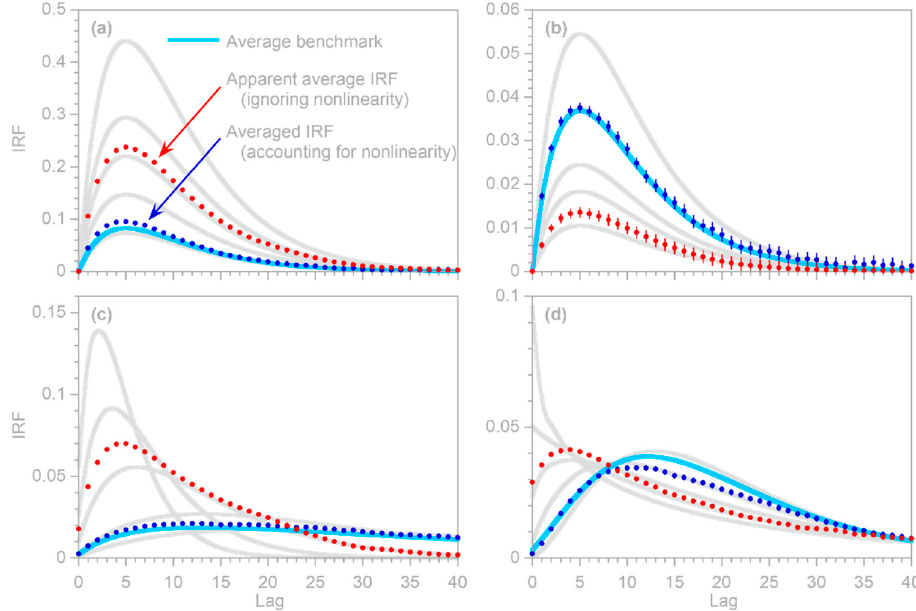
Figure 14. Bias in apparent average impulse response in four nonlinear benchmark systems. Bench ‐ marks include ( a ) quadratic relationship between input and output (Figure 10); ( b ) Michaelis–Men ‐ ten relationship between input and output (Figure 11e); ( c ) gamma mean lifetime decreases with increasing input (Figure 12); ( d ) gamma shape factor decreases with increasing input (Figure 13). Test procedures are identical to Figures 10–13, except signal ‐ to ‐ noise ratio is 100 so that mean IRFs are shown with minimal scatter. Gray lines show benchmark impulse responses at knot values 𝑥 (cid:3404) 𝜅 ℓ ; these are not evenly spaced either in 𝑥 or in percentiles of 𝑥 , and thus the spacing between the gray lines does not indicate the underlying degree of nonlinearity. Light blue lines show the average benchmark impulse response functions for each system, averaged over all values of 𝑥 . Dark blue points show the average impulse response functions estimated from Equations (43) and (47). These estimates generally follow the average benchmarks. Dark red points show naïve estimates of impulse response functions estimated using the methods of Sections 2.1–2.4, without accounting for the systems’ nonlinear behavior. These naïve estimates can be much larger ( a ) or smaller ( b ) than the benchmark average impulse response functions shown by the blue lines, or have a substantially different shape ( c , d ). Error bars show 1 standard error, wherever this is larger than the plotting symbols. The substantial biases in these naïve estimates motivate the question of how the av ‐ erage impulse response functions 𝛽̅ (cid:3038) can be estimated in nonlinear systems. The straight ‐ forward answer is that once the incremental impulse response coefficients 𝛽 ℓ,(cid:3038)(cid:4593) have been estimated by regression via Equation (44), one can use Equations (43) and (47) to calculate 𝛽 (cid:3038) (cid:4666)𝑥(cid:4667) and 𝑦 (cid:3038) (cid:4666)𝑥(cid:4667) for any value of 𝑥 , and thus calculate their average from the distribution of 𝑥 . These estimates of 𝛽̅ (cid:3038) , shown by the blue dots in Figure 14, generally follow the average benchmarks shown by the blue lines. 6. Capturing Multiscale Impulse Response with Unevenly Spaced Piecewise Linear IRFs Many systems exhibit impulse response over multiple time scales, often starting with a sharp, brief initial response, which then transitions to a persistent lower ‐ level response that decays much more slowly. It is difficult to capture these different timescales with a conventional IRF defined by coefficients for evenly spaced lag times. In principle, of course, one could simply use the methods of Sections 2–5 to evaluate IRF coefficients over hundreds or thousands of lags, extending out to the longest lag time of interest. Doing so, however, is computationally inefficient: although it is possible to evaluate IRFs over thousands of lags, the necessary matrix operations become time ‐ con ‐ suming (see Section 2.2), although modern matrix solvers make this issue much less press ‐ ing than it once was. A more serious problem is that it is also statistically inefficient to